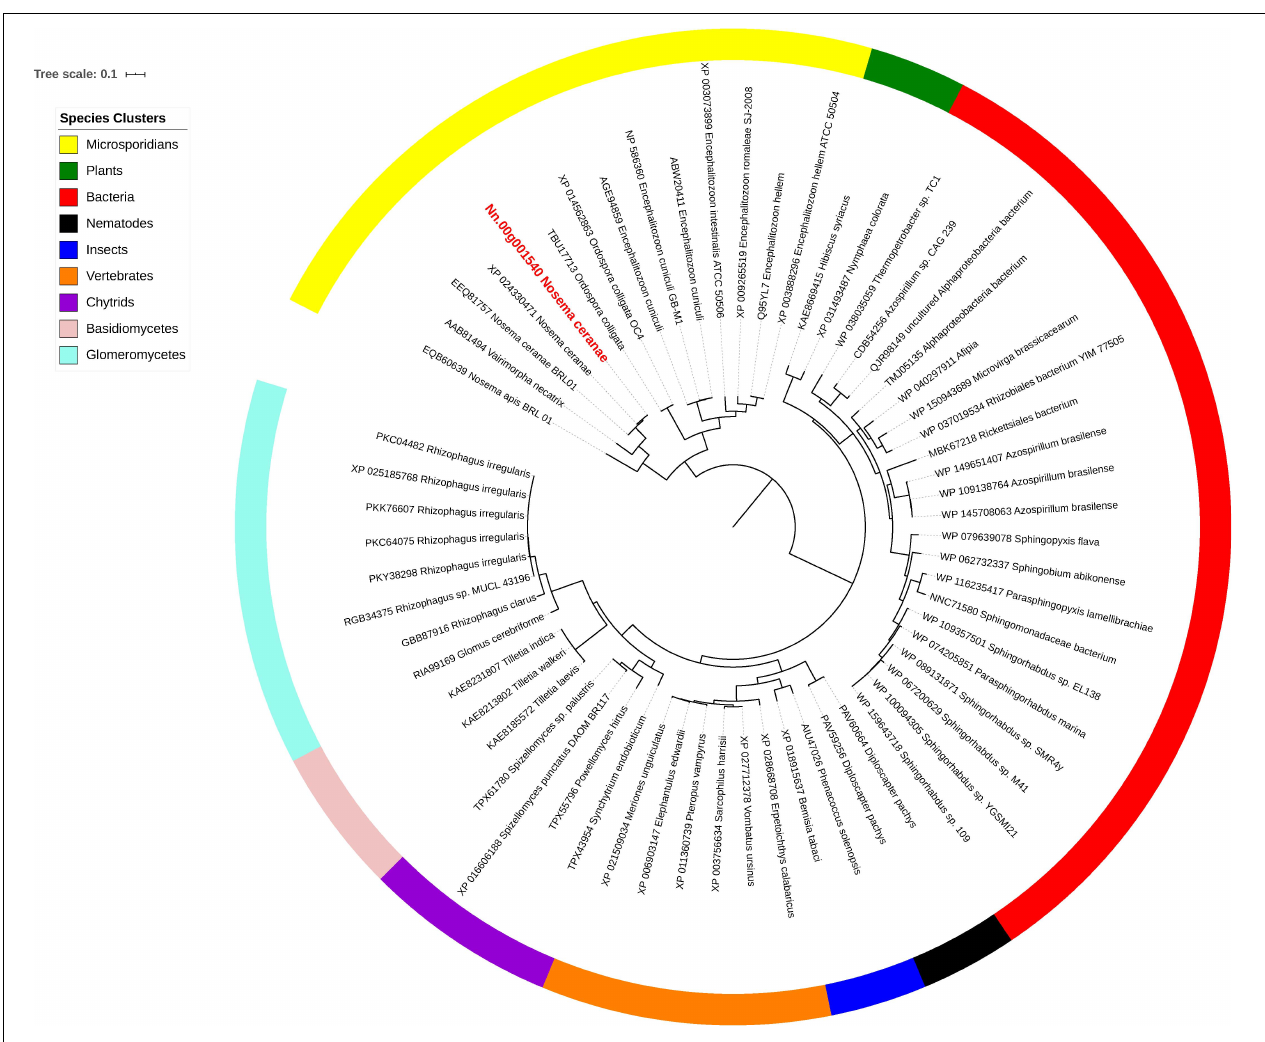
FIGURE 7 | Maximum likelihood phylogenetic tree of Hsp70 proteins. Branches are labeled as GenBank accession numbers followed by species names. Branches with bootstrap values (1,000 replicates) less than 0.5 were discarded. The genetic distance is drawn to scale. The current Nosema ceranae record is highlighted with red color. The definitions of the species clusters are adopted from NCBI Taxonomy